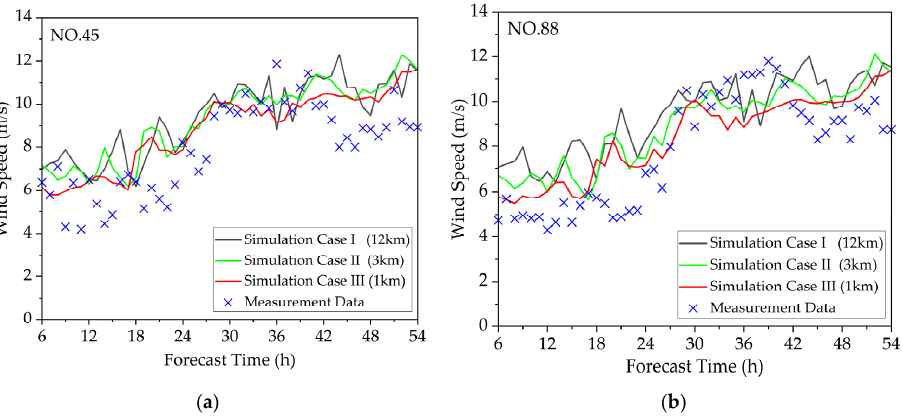
Figure 7. The simulation results and measurement data of wind speed for NO.45 and NO.88 turbine: ( a ) the temporal distribution of wind speed from observation data and simulation results with three horizontal resolutions for NO.45 turbine; ( b ) the temporal distribution of wind speed from observation data and simulation results with three horizontal resolutions for NO.88